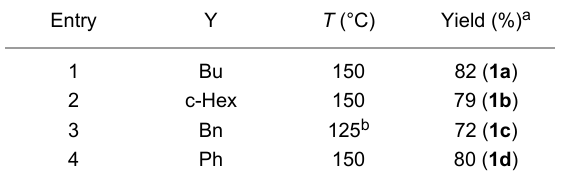
Table 1: Synthesis of alkylamino- and (phenylaminomethylene)bispho- sphine oxides 1a–d